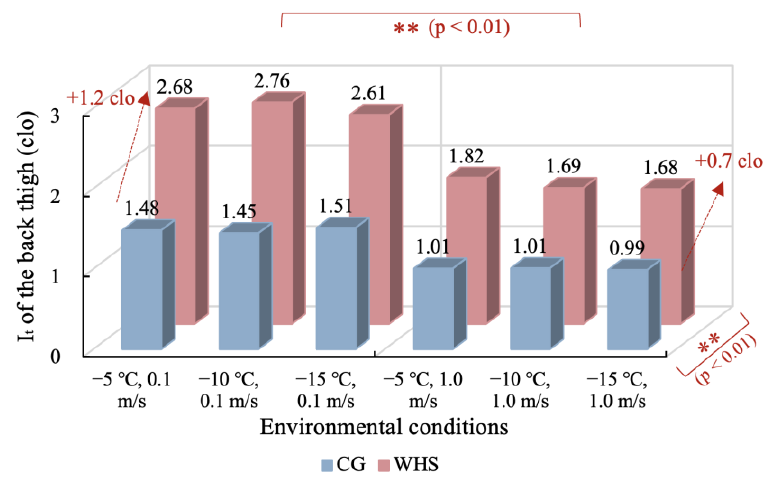
Figure 10. I t , back thigh of CG and WHS in different environmental conditions.